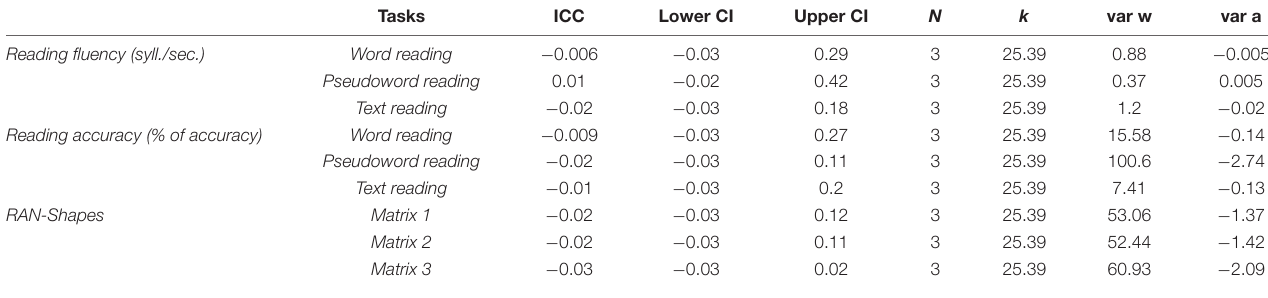
TABLE 2 | Intraclass Correlation Coefficient (ICC) calculated to evaluate whether the three levels of Socio-Economic Status (SES) (high–medium–low) clustered reading and Rapid Automatized Naming (RAN) performances. Tasks